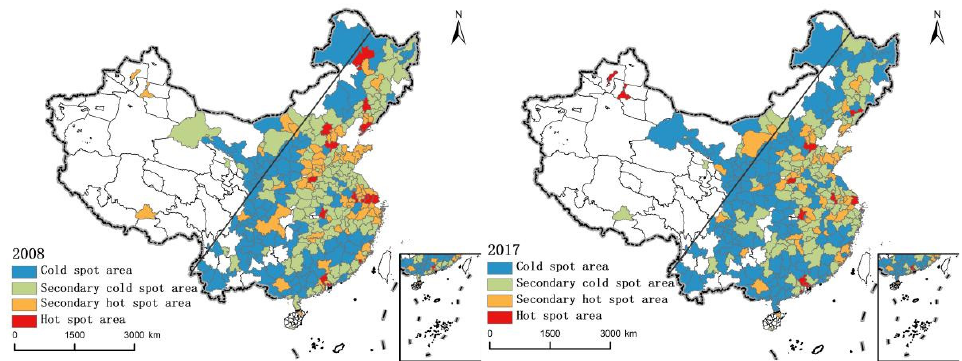
Figure 3. Spatial pattern of “production-living-ecology” functional coordination in China from 2008 to 2017.